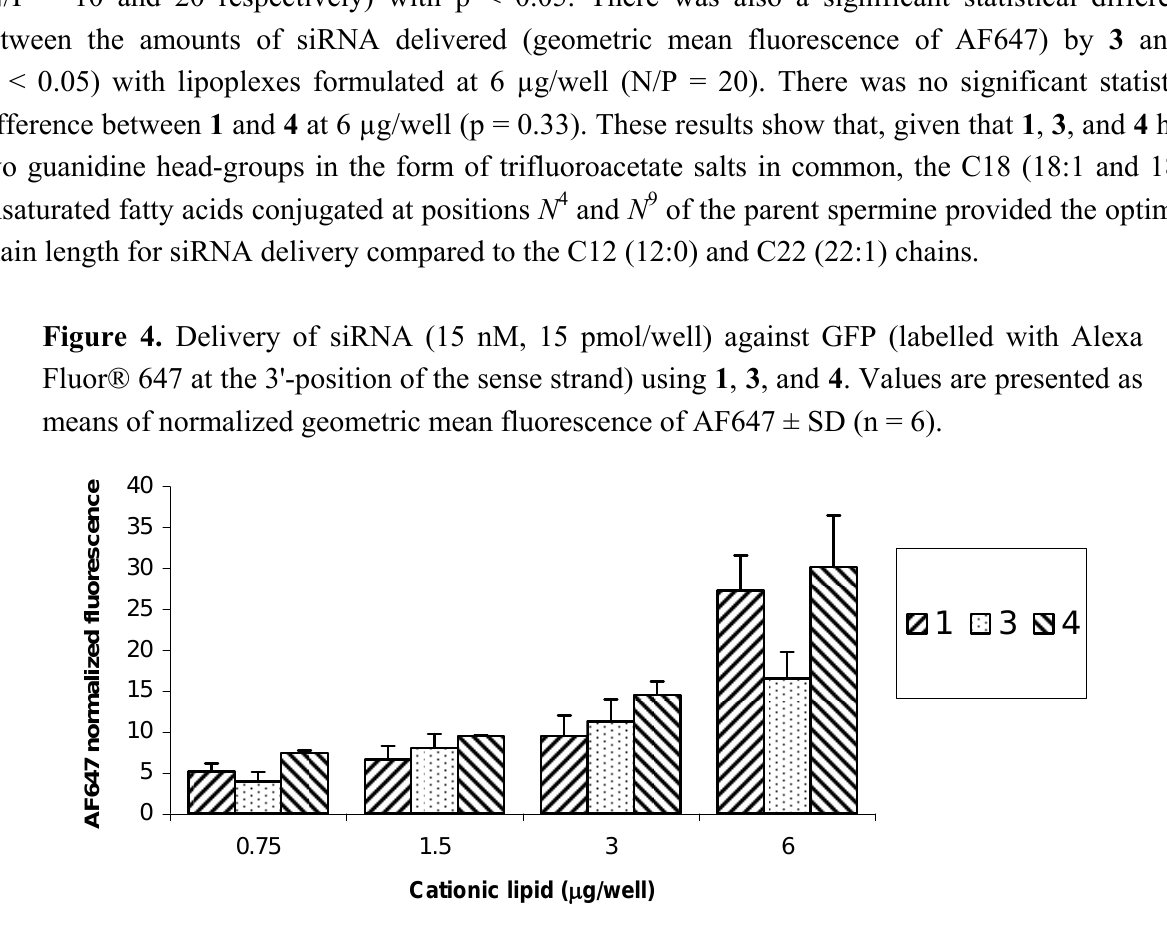
Figure 5. Reduction in GFP expression in HeLa cells after transfection with lipoplexes of 1 , 2 , 3 , and 4 at different cationic lipid/siRNA ratios. siRNA concentration is kept constant (15 nM, 15 pmol/well). Values are presented as mean ± SD (n = 6). Commercial TransIT TKO (T) is shown for